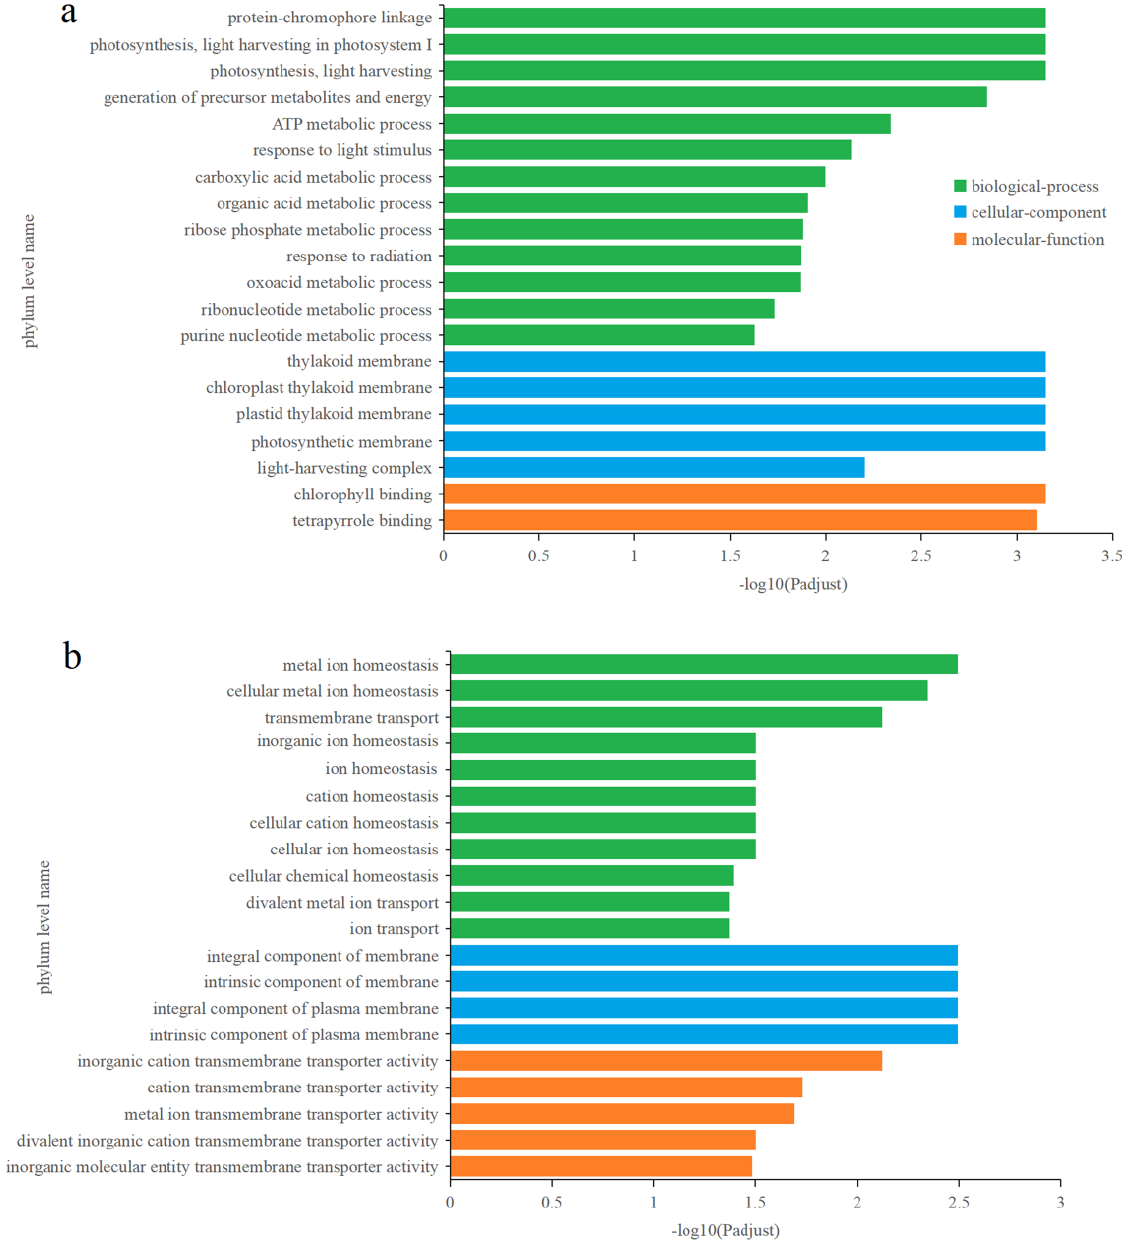
Table 1. DEGs involved in heavy metal stress response in P. tricornutum under Cu 2+ . Gene_id fc Regulate